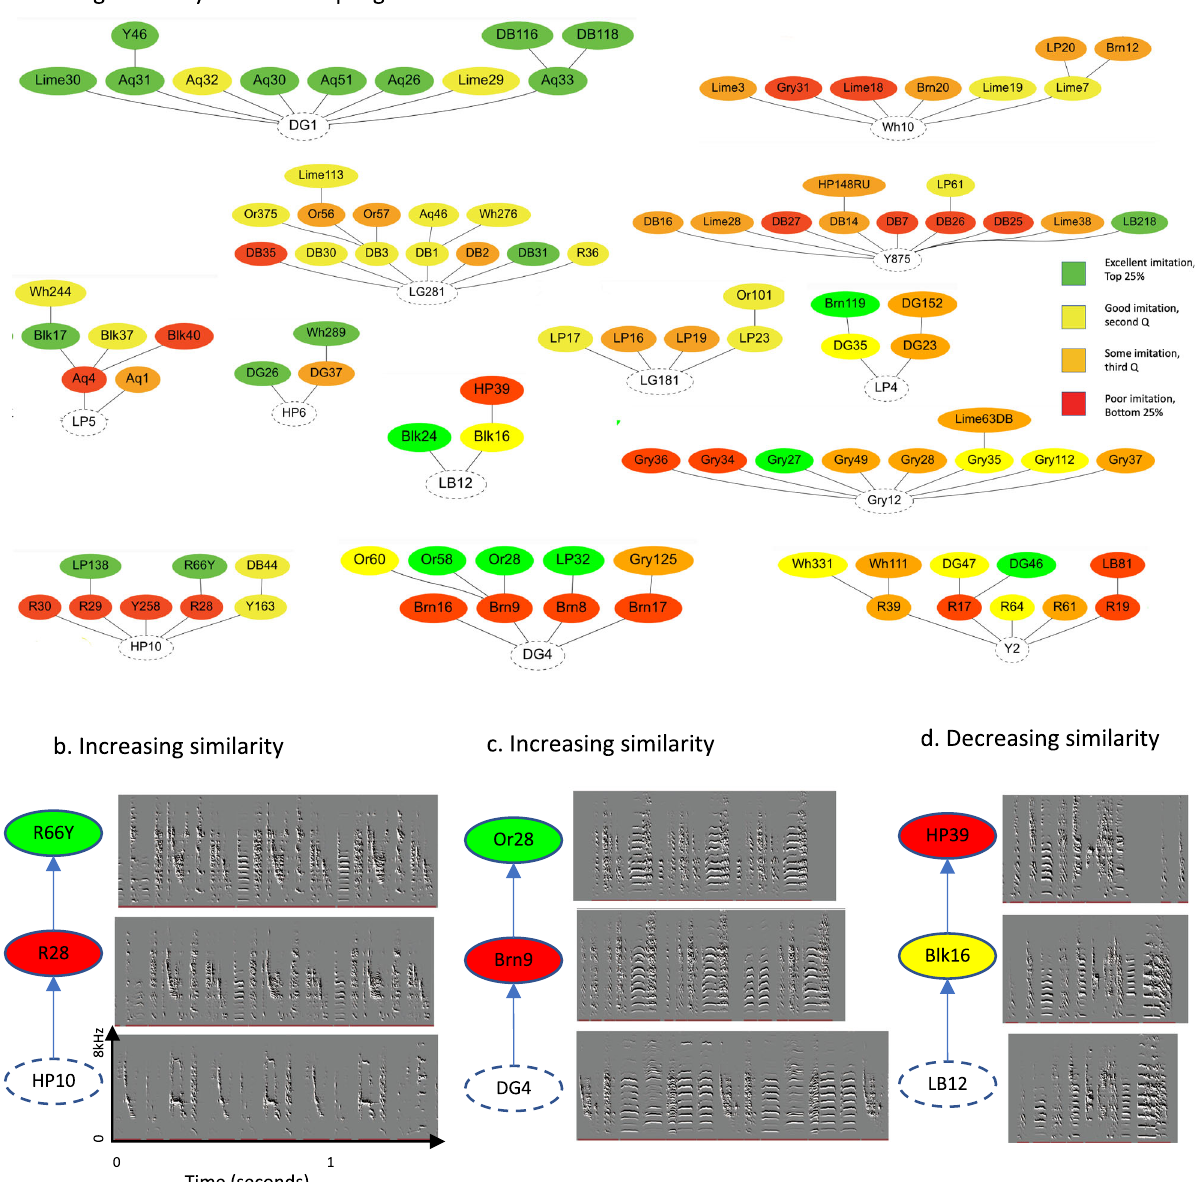
Fig. 5 Song diversity across generations. a Song similarity across two generations of pupils (colors represent quartiles (as in Fig. 1a)) in 14 family lineages. b An example from lineage HP10 showing a transition from poor imitation in a fi rst-generation pupil to accurate imitation in a grand pupil. c Same as b for lineage DG4. d A counter example in lineage LB12, where the grand pupil imitated poorly. Source data for this fi gure is in Supplementary Data File